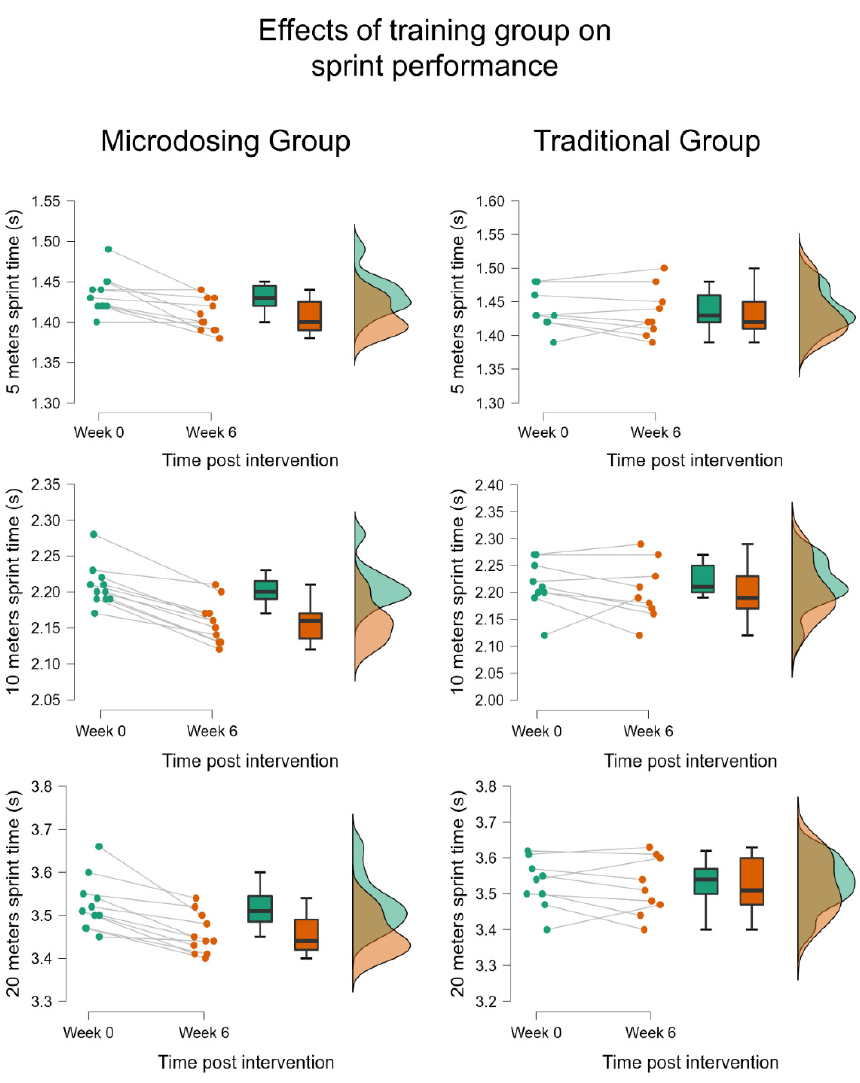
Figure 2. Effects of training group on sprint performance. Colours are indicating the values before (green) and after the training intervention (orange). But it is the same in the left and right columns because the left column is for Microdosing group and right column is for the traditional group.